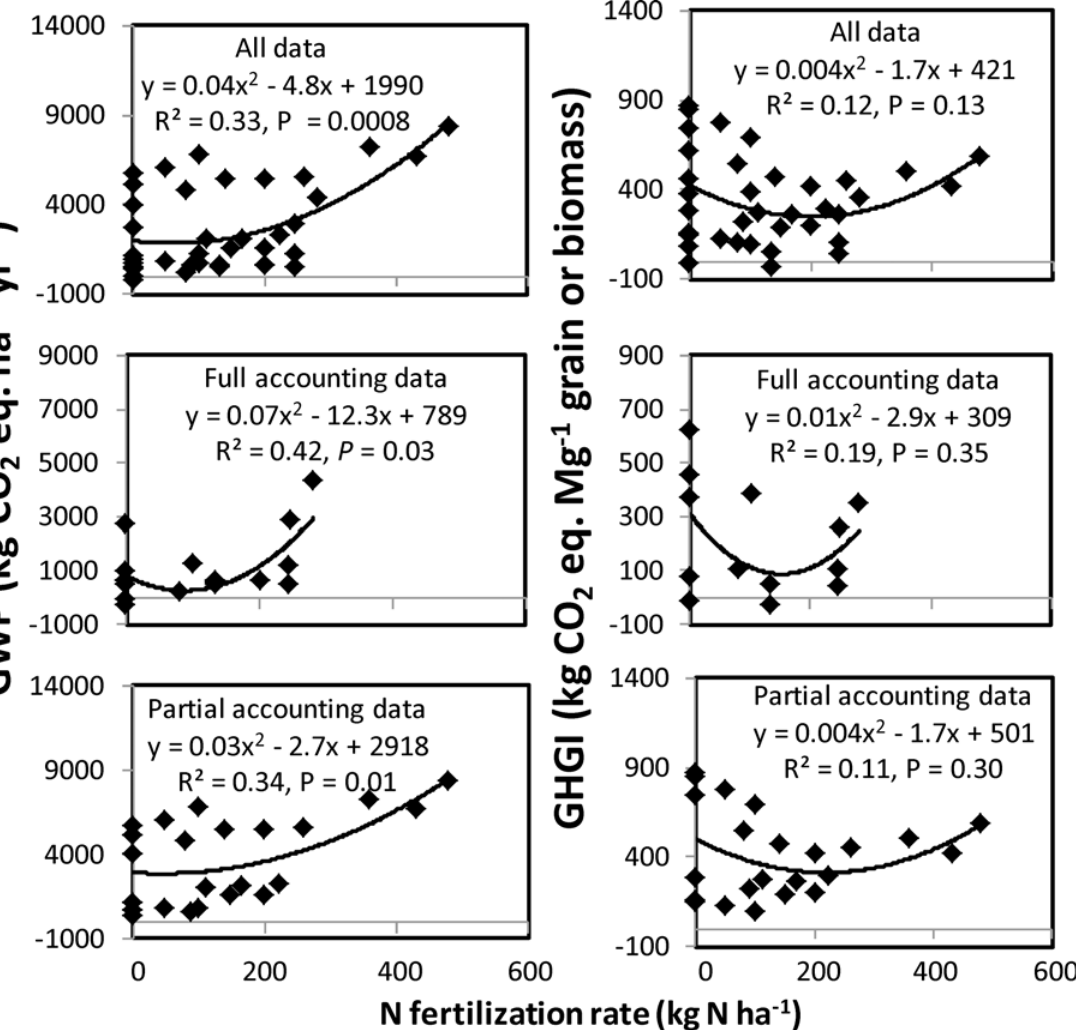
Fig 4. Relationship between N fertilization rate and net global warming potential (GWP) and greenhouse gas intensity (GHGI) using the soil organic C method. Full accounting data denote calculations of GWP and GHGI by accounting all sources and sinks of CO 2 (N 2 O and CH 4 emissions, farm operations, inputs, and soil C sequestration) and Partial accounting data, partial accounting of sources and sinks (N 2 O and CH 4 emissions and/or soil C sequestration). All data denotes inclusions of full and partial accounting